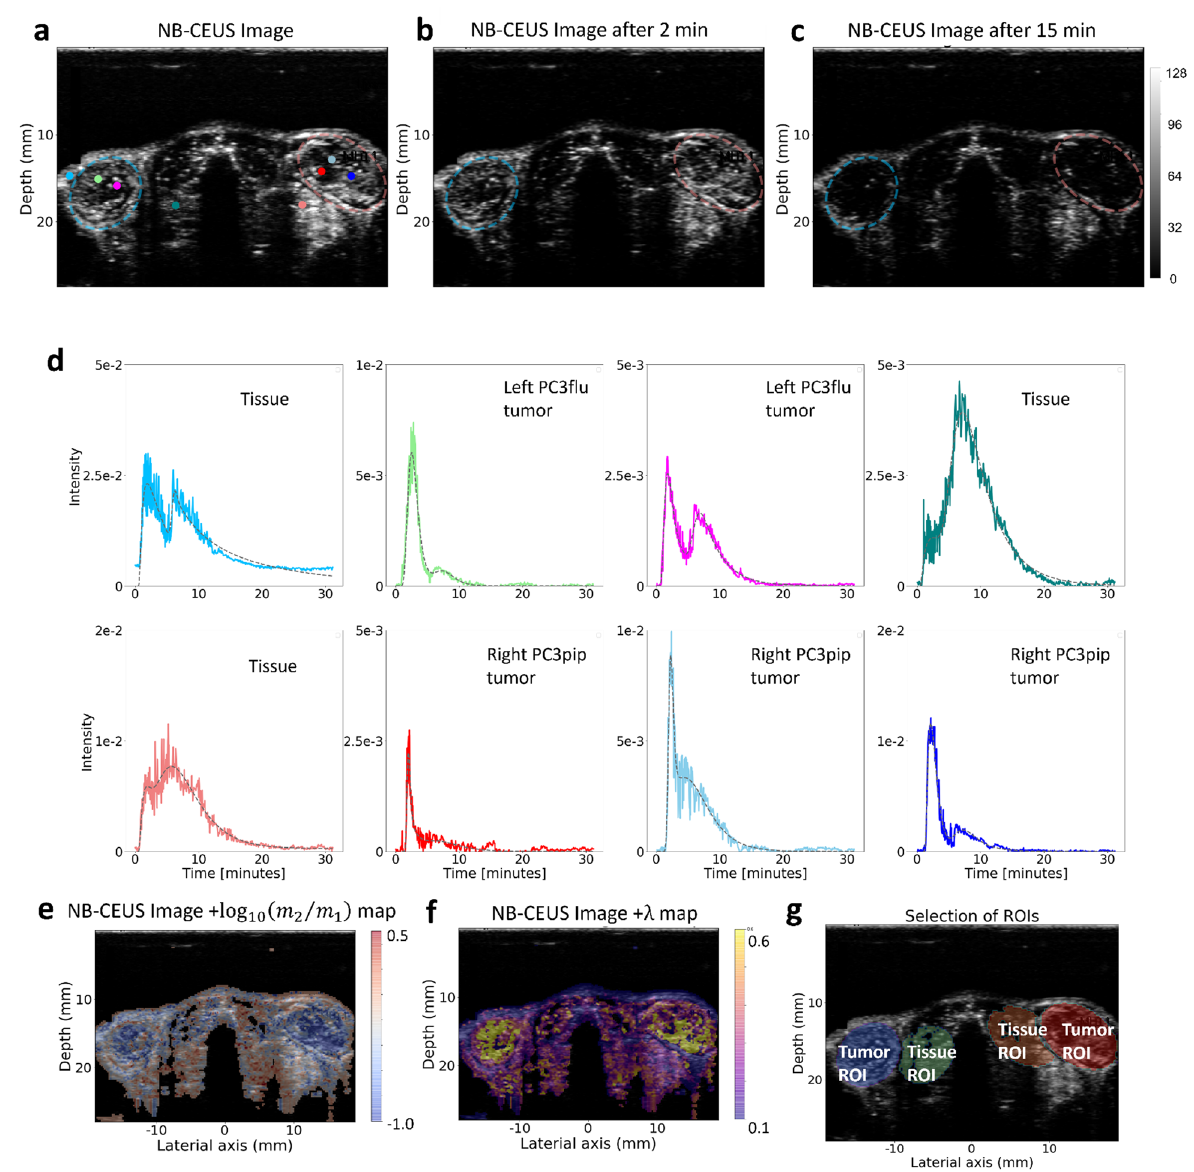
Figure 2. An example of pixel-based TICs and parametric maps in mouse dual-tumor model. ( a ) presents the NB-CEUS image of overall highest enhancement, with the left PC3flu and right PC3pip tumor ROIs delineated in blue and red, respectively. The NB-CEUS images acquired at time 2 and 15 min after the injection are displayed ( b ) and ( c ), respectively. In ( d ), a series of experimental pixel-based TICs (colored solid lines) and corresponding model fit (gray dashed lines) are extracted from different locations which are indicated by the corresponding colored dots in ( a ). The classification of each dot’s location is labelled out. The scales of y-axis varies between subfigures in ( d ). ( e ) and ( f ) present the overlays of parametric maps of log 10 ( m 2 / m 1 ) and (cid:31) upon the NB-CEUS projection image, respectively. In ( g ) the ROIs corresponding to tumor and tissue are indicated by colored